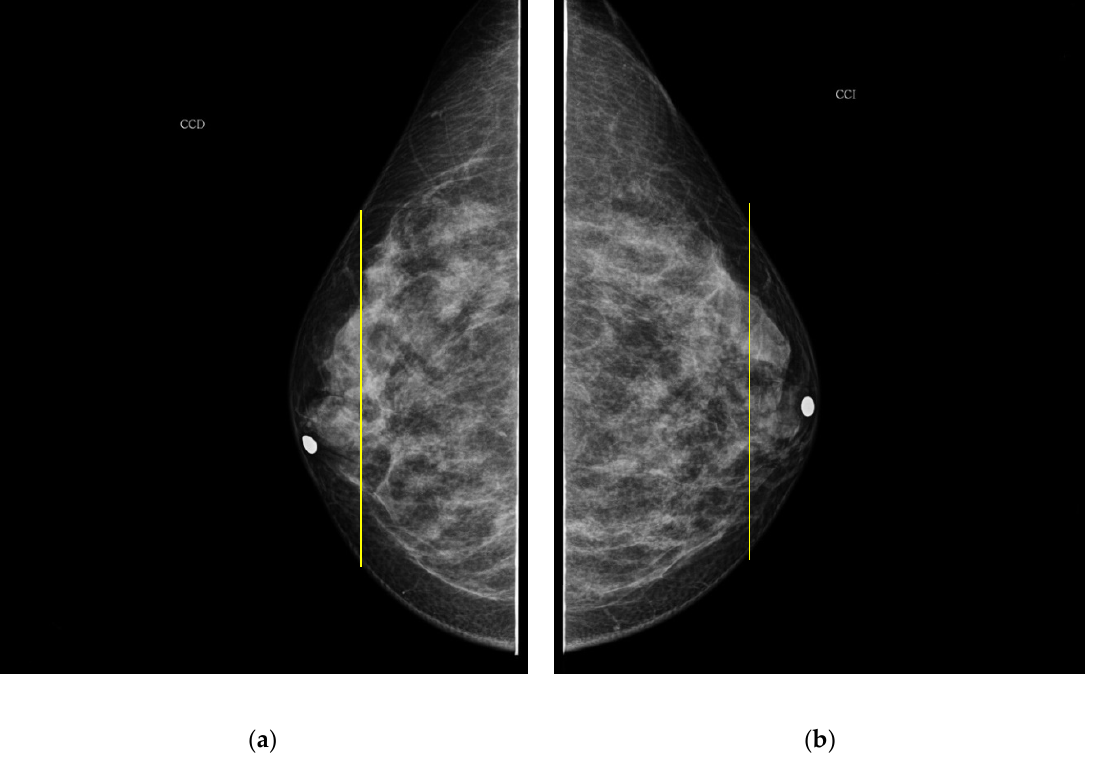
Figure 6. CC mammogram images of participant 9 and relative electrode ring position (yellow vertical line): ( a ) right breast; ( b ) left breast.